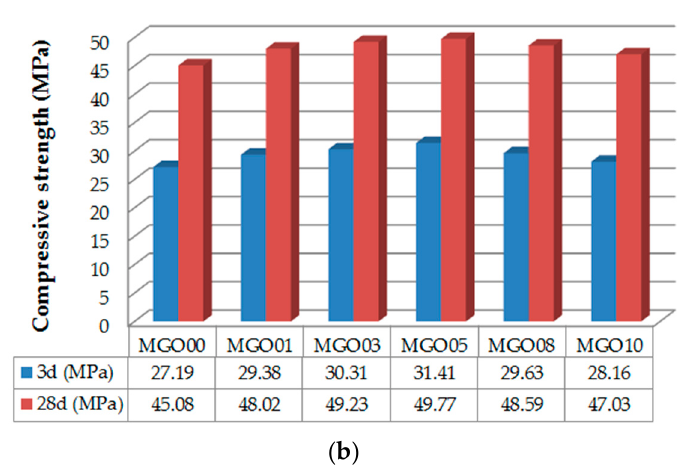
Figure 5. ( a ) Flexural strength and ( b ) compressive strength of GONSs-incorporated mortars.